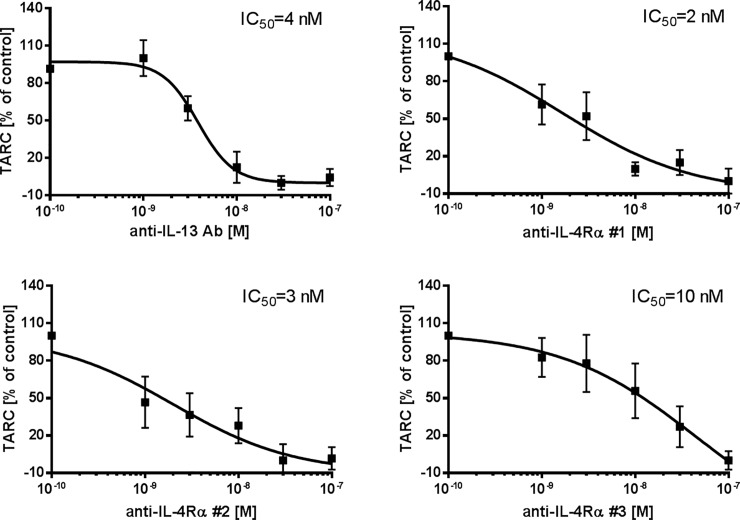
Inhibitory effects on IL-13-induced TARC production.Human PCLS were co-stimulated with 10 nM IL-13 and increasing concentrations of the antagonists a) anti-IL-13 Ab (n = 6), b) anti-IL-4Rα #1 (n = 5), c) anti-IL-4Rα #2 (n = 5), and d) anti-IL-4Rα #3 (n = 4). Results are displayed as the sum of intra and extracellular cytokines and normalized (as a percentage) to the untreated tissue control. Curve fitting was performed by non-linear regression analysis based on four parameters. Data are presented as mean ± SEM.